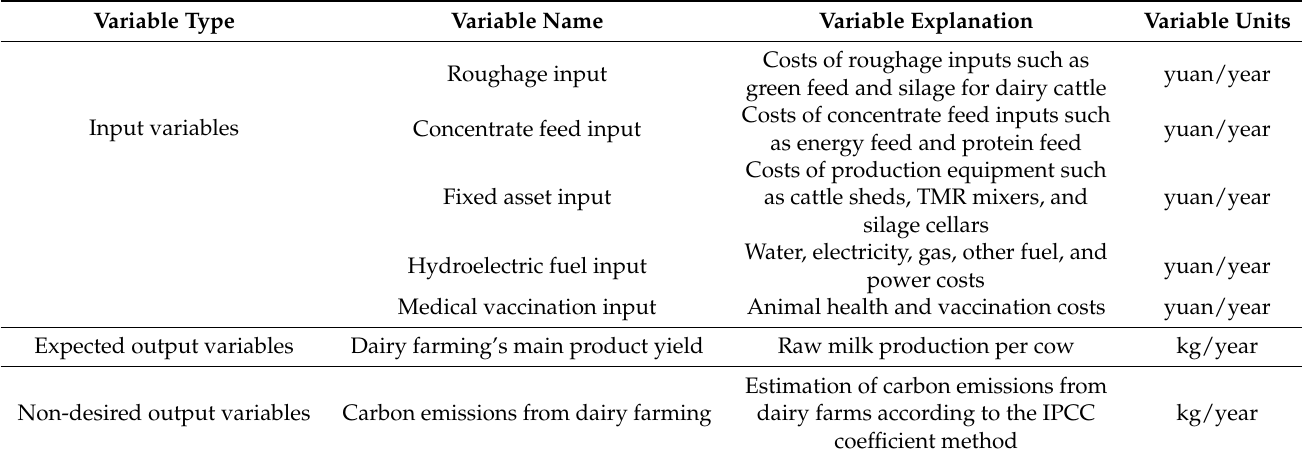
Table 1. The carbon emission efficiency evaluation index system of dairy